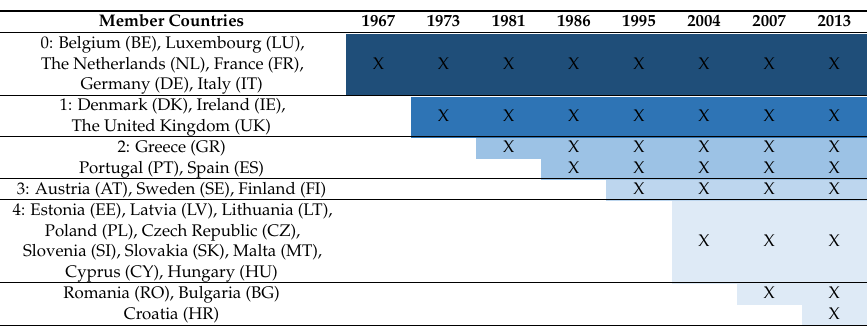
Table 1. Stages of the European Union enlargement.